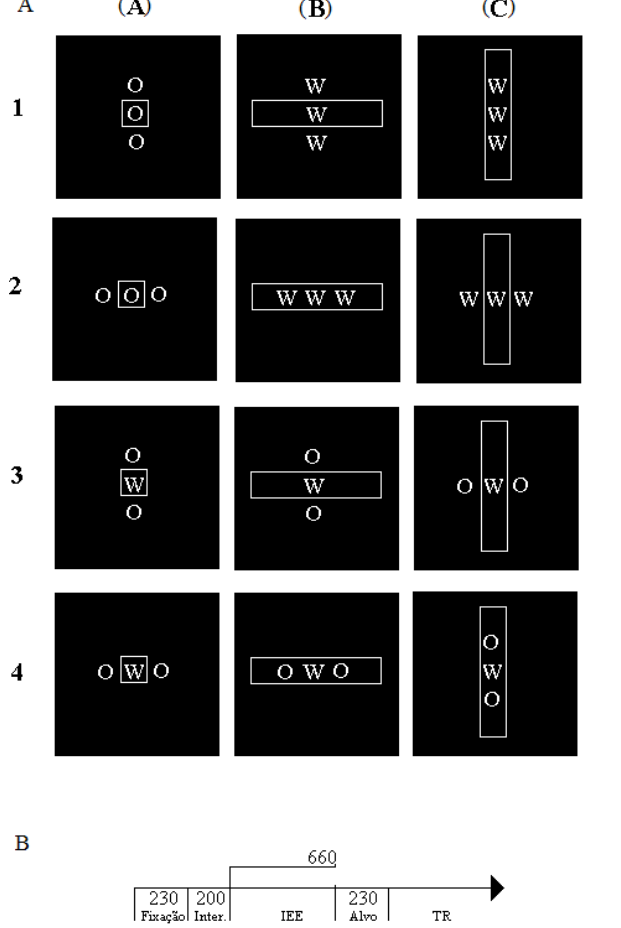
Figura 3. A- Representação esquemática dos estímulos apre- sentados no Experimento 2. B- Seqüência de eventos apresentados em cada prova. As colunas A, B e C, mostram exemplos das dicas visuais, respectivamente, dica controle, dica horizontal e dica vertical. As linhas 1, 2, 3 e 4, mostram os possíveis arranjos apresentados, respectivamente, letras compatíveis na vertical, letras compatíveis na horizontal, letras incompatíveis na